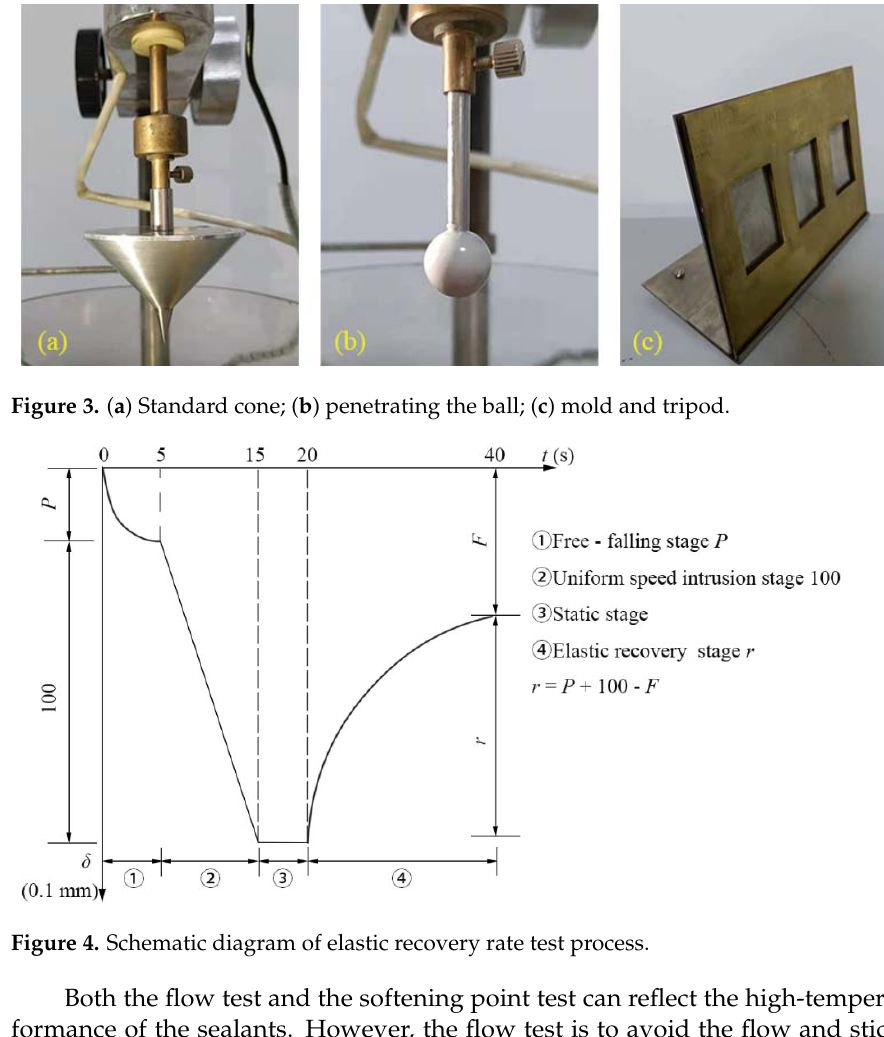
Figure 5. Preparation of DSR test samples ( a – d ). 2.3.4. LAS Test The standardized LAS procedure (AASHTO TP 101) was divided into two stages [32]. First, the frequency scanning test was carried out to test the non ‐ destructive rheolog ‐ ical properties of the samples. Then a linear amplitude scanning (LAS) test with a strain amplitude of 0.1% to 30% was carried out to test the damage tolerance of the sample. Therefore, in this study, the multi ‐ temperature frequency sweep tests were carried out under a strain amplitude of 0.1% ( ≤ LVE 